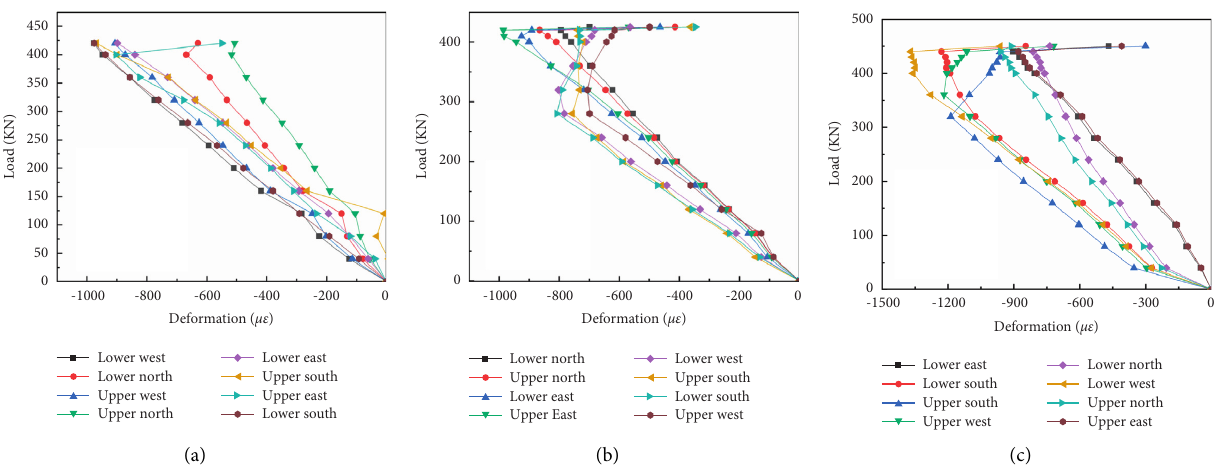
Figure 41: ZF series of load-strain curves: (a) ZF-1, (b) ZF-2, and (c) ZF-3.